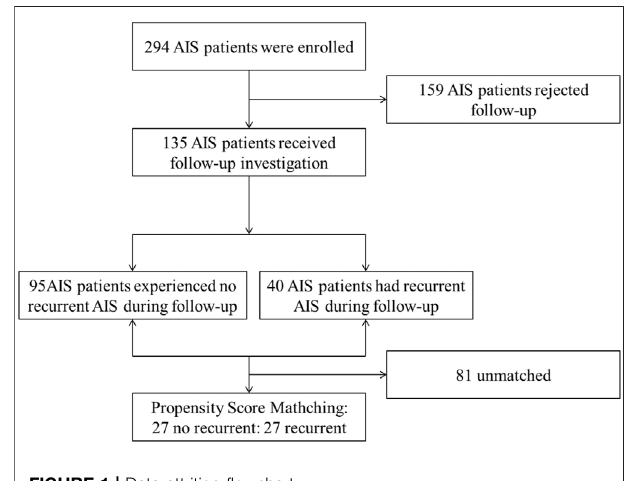
FIGURE 1 | Data attrition fl